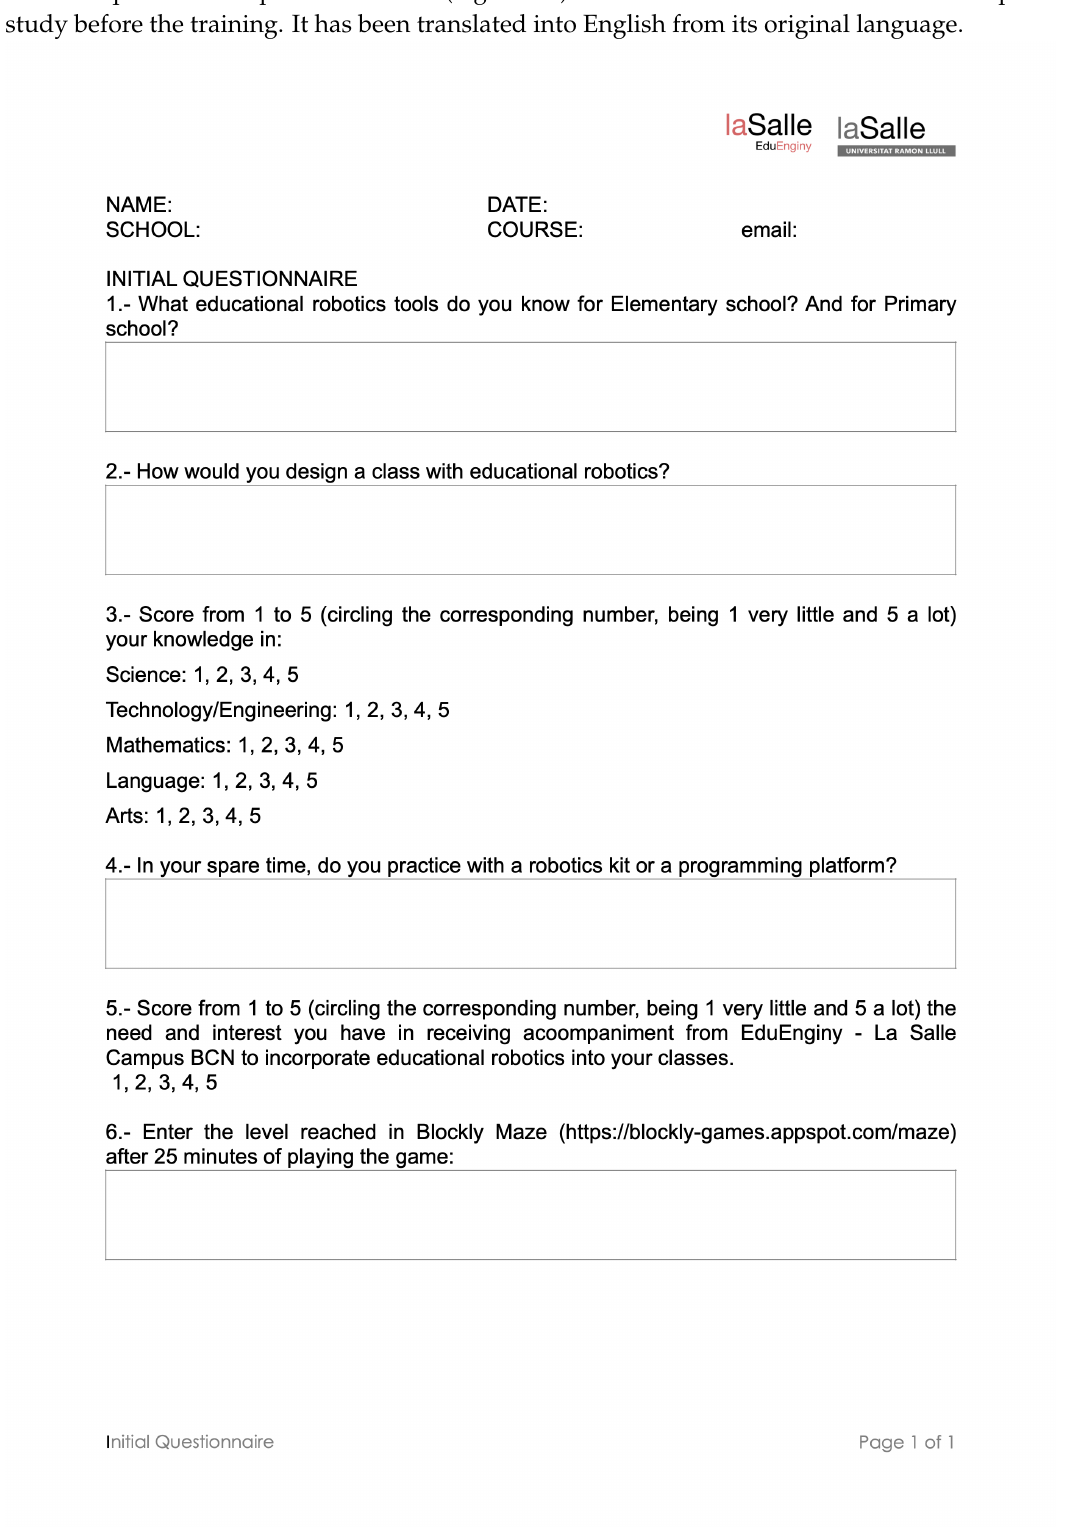
Figure A2. Questionnaire delivered to the teachers participating in this study before the